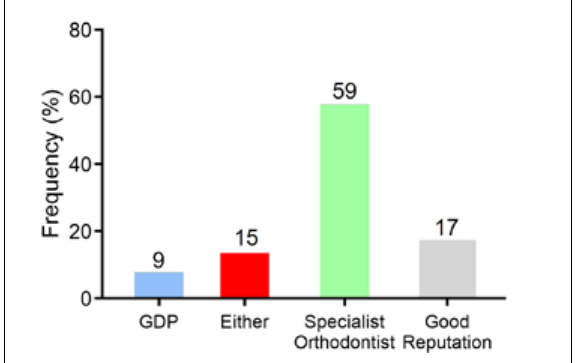
experiencegeneral dentist all equalspecialist orthodontistgeneral dentist with orthodontic Most qualified to perform orthodontic treatment Figure 12. Responses to Question 4 stratified by the type of practitioner that had previously provided orthodontic treatment to either the respondent or their family